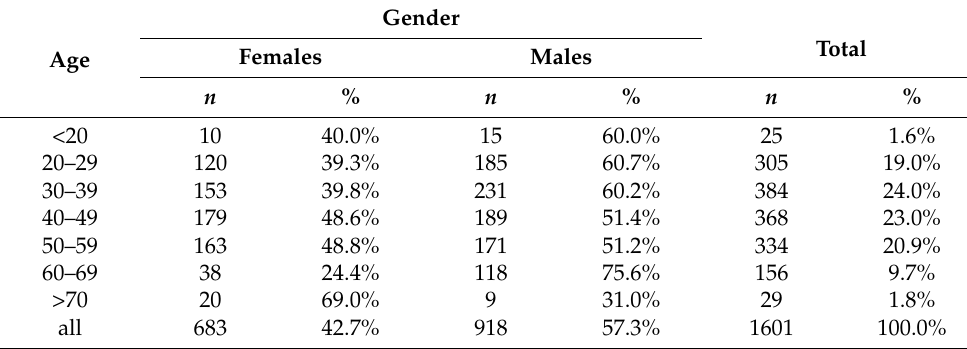
Table 2. Interventions of emergency medical services teams in the workplace considering the patient’s age and gender.